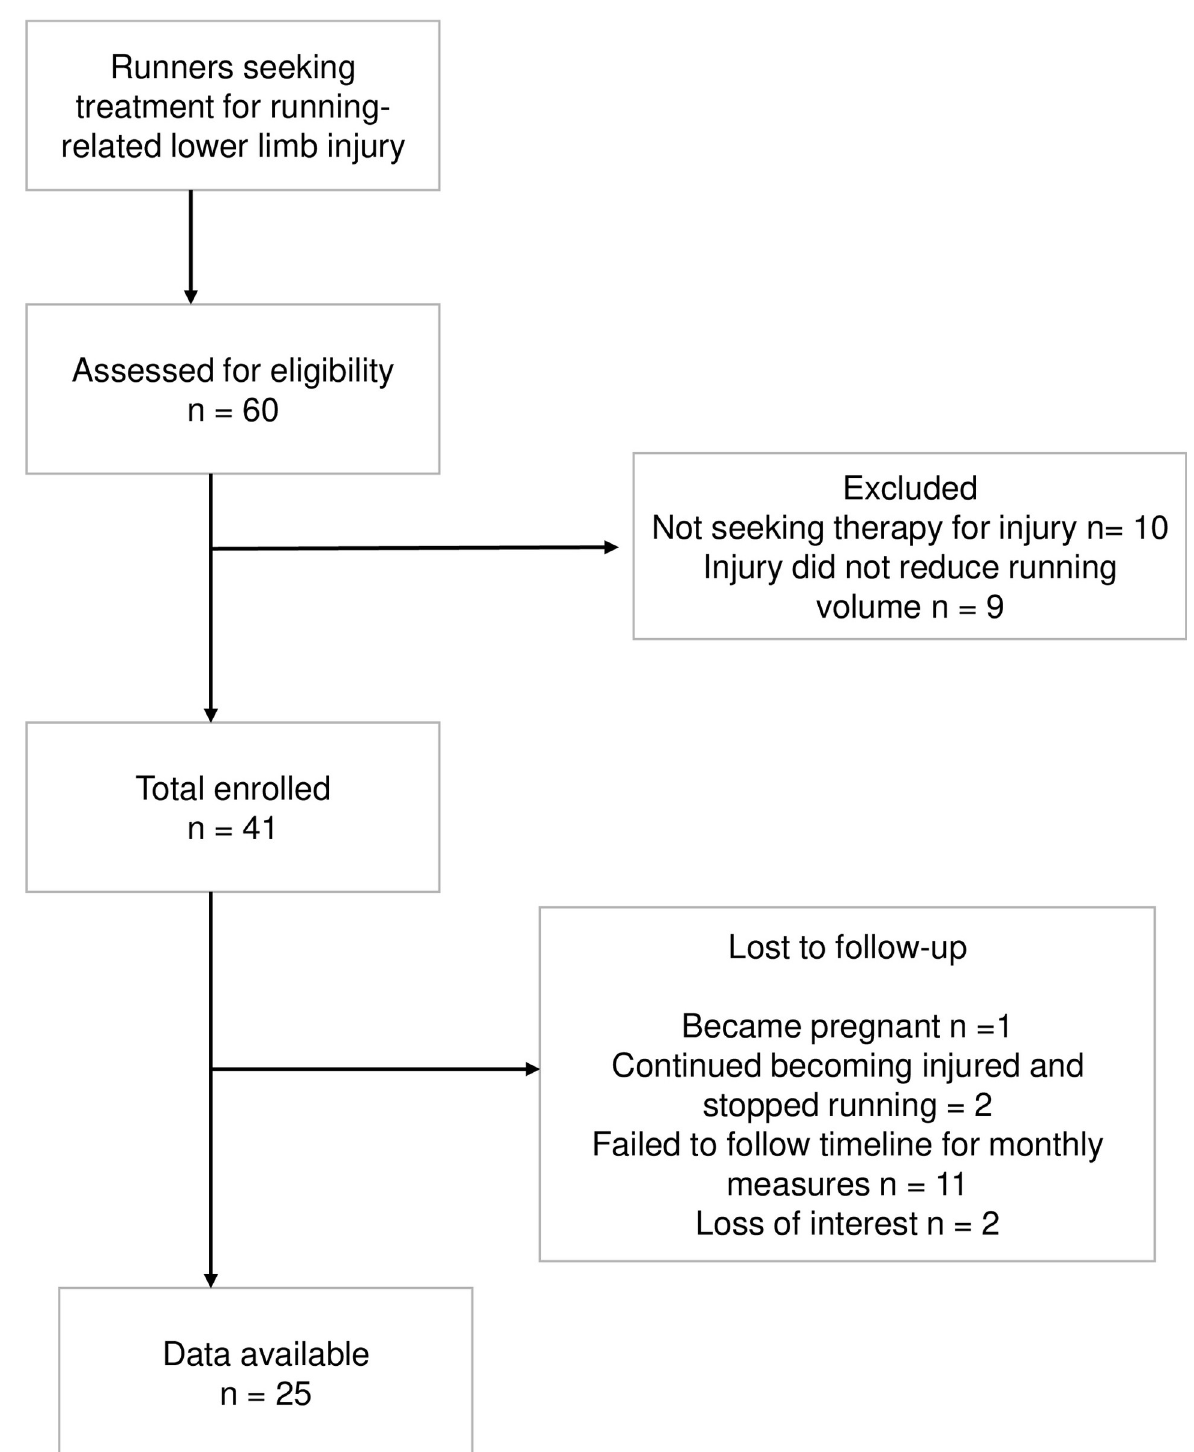
Fig 2. Study flow diagram.